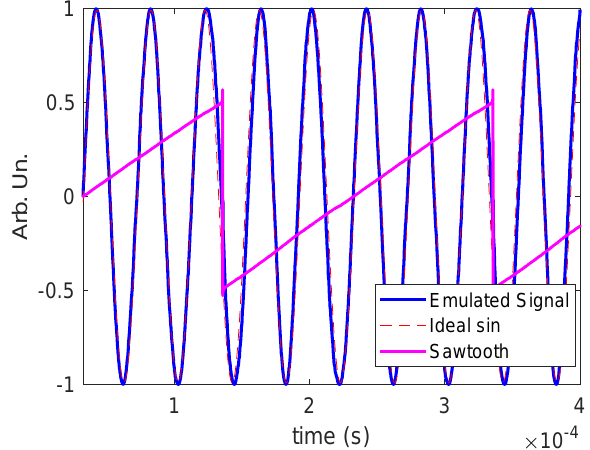
Figure 16. Emulated sinusoid of (2) when the sawtooth is 5 kHz, R IN = 4.7 Ω in Figure 8 and Equation (9), the generated sinusoid is at 25 kHz and γ = 6. This is the minimum frequency and number of transformers needed to obtain a signal similar to that obtained from the input